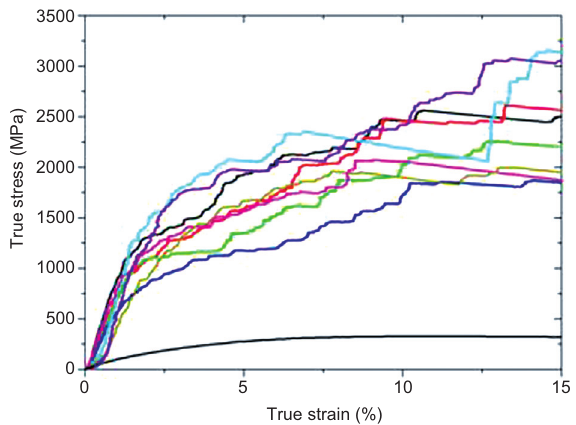
Figure 1 Top, Stress-strain curves of [100]-oriented Mo micropillars, mean diameter d = 0.3 μm [1, 2]. Bottom, Room temperature stress-strain curve of macroscopic [100]-oriented Mo single crystal (after Hollang et al.